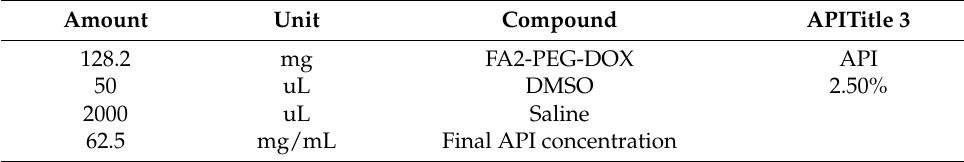
Table 1. The FA 2 -dPEG-DOX 2 solution composition used in the imaging